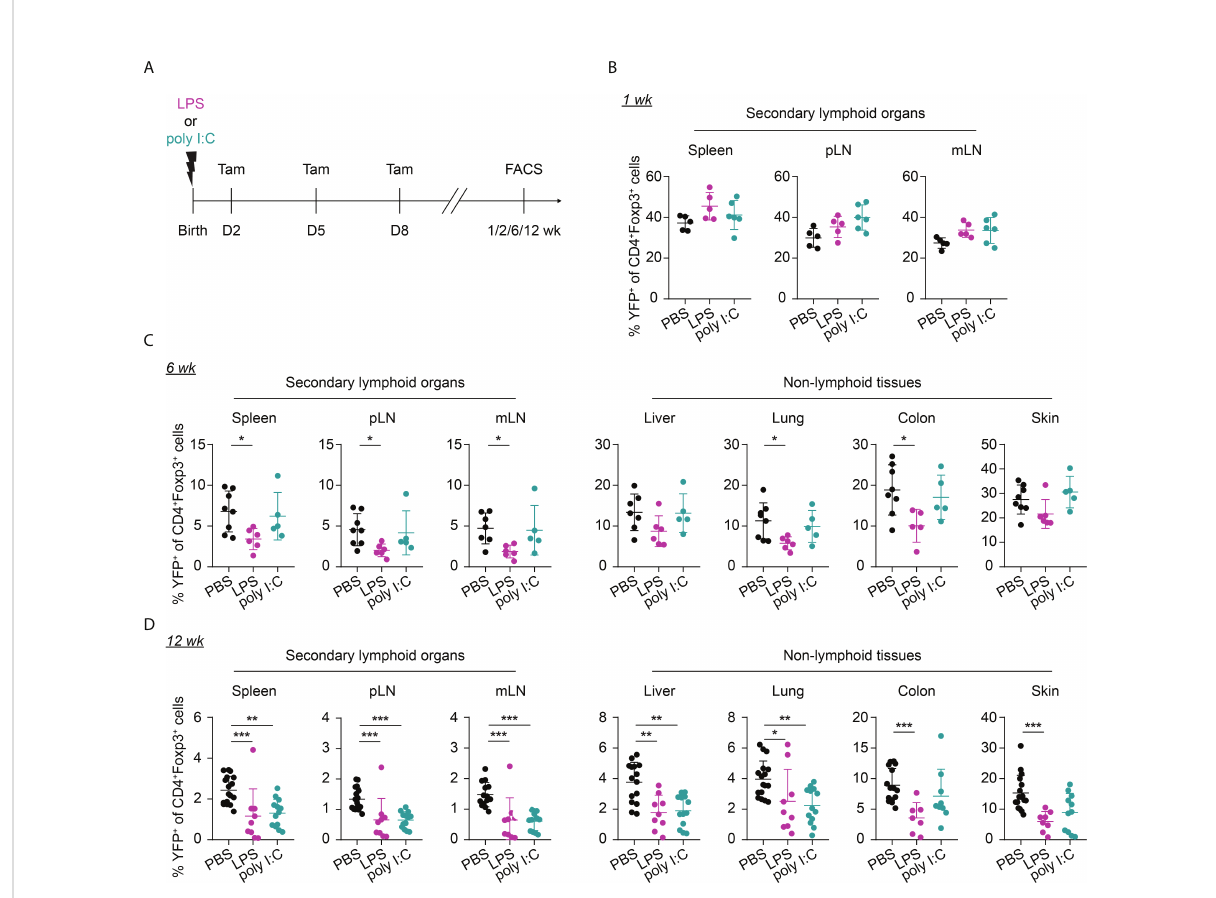
FIGURE 3 Long-term impact of neonatal in fl ammatory perturbations on neonatally-tagged Tregs. (A) Newborn Foxp3 eGFPCreERT2 xROSA26 STOP-eYFP mice were intraperitoneally injected with LPS, poly I:C or PBS as control, received repetitive intragastric injections of tamoxifen at days 2, 5 and 8 after birth, and were sacri fi ced at indicated time points after challenge. (B – D) Scatter dot plots summarize frequencies of neonatally-tagged (YFP + ) Tregs among Foxp3 + Tregs across indicated organs of LPS- (purple), poly I:C- (turquoise) or PBS-treated mice (black) 1 (B) , 6 (C) and 12 (D) weeks post in fl ammatory perturbation. Data in scatter dot plots are depicted as mean ± SD, each dot represents a single mouse, and data were pooled from 4 to 6 independent experiments (n = 5-11). * p < 0.05, ** p < 0.01, *** p <